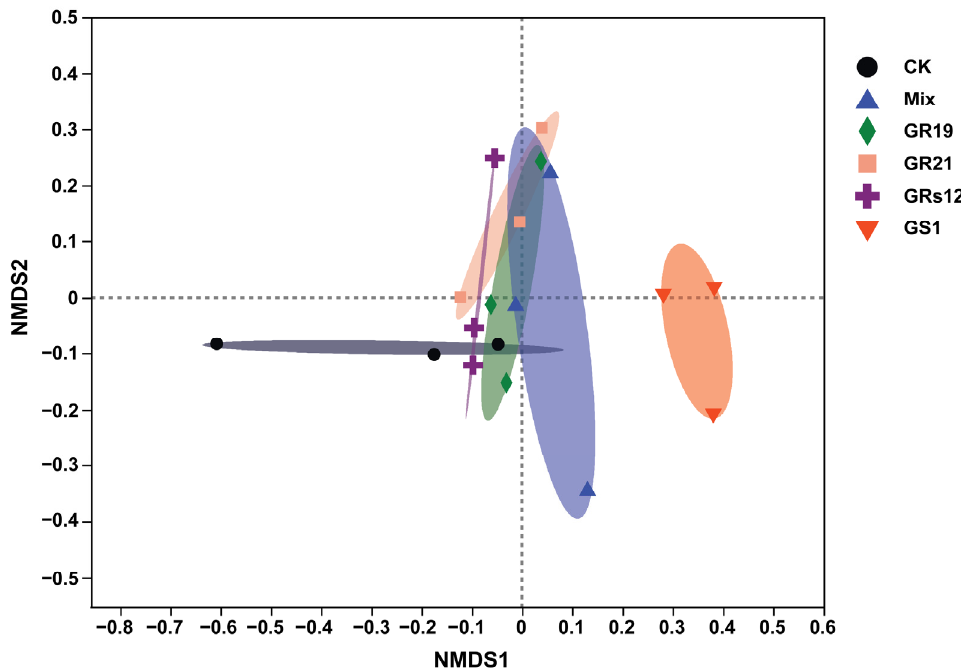
Figure 4 . The non-metric multidimensional scaling analysis of fungal communities of mulberry rhizosphere soils using Bray-Curtis distances based on the genus level. GS1, GRs12, GR19, GR21, Mix, and CK represented mulberry seedlings treated with Talaromyces sp. GS1 at the initial concentration, Pseudeurotium sp. GRs12 at the initial concentration, Penicillium sp. GR19 at the 10-fold diluted suspensions, Trichoderma sp. GR21 at the 10-fold diluted suspensions, mixed fungi at the 100-fold diluted suspensions, and water, respectively.